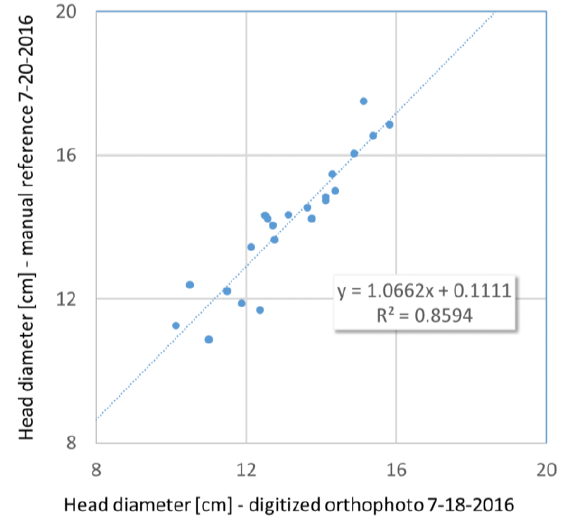
Figure 10: Relationship of cauliflower head size measured manually vs. digitized orthophoto, N = 25 lines (200 measurements)